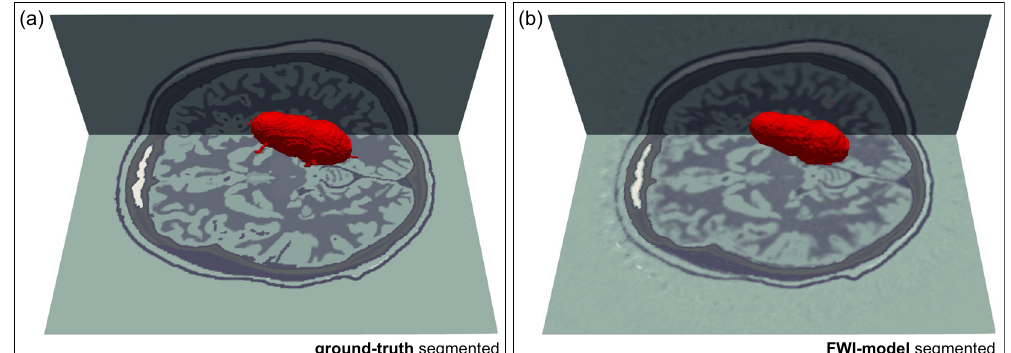
Fig. 9 Segmented haemorrhage. a Haemorrhage auto-segmented from the true model. b Haemorrhage auto-segmented from the model recovered by full-waveform